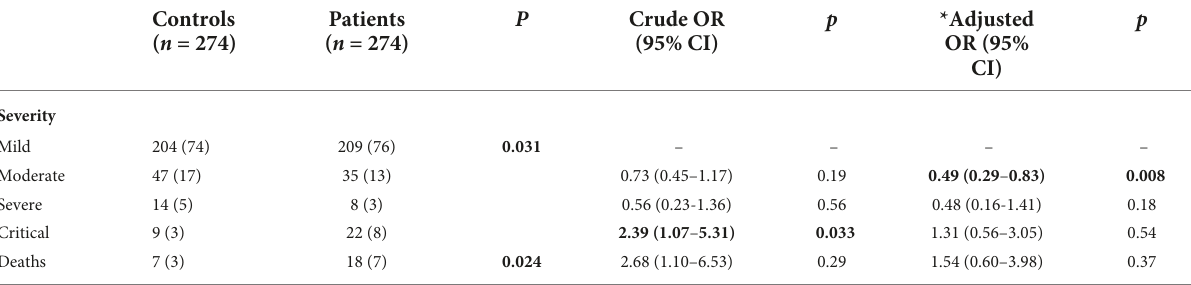
TABLE 4 Coronavirus disease 2019 (COVID-19) severity and deaths in patients and controls. Controls ( n = 274)